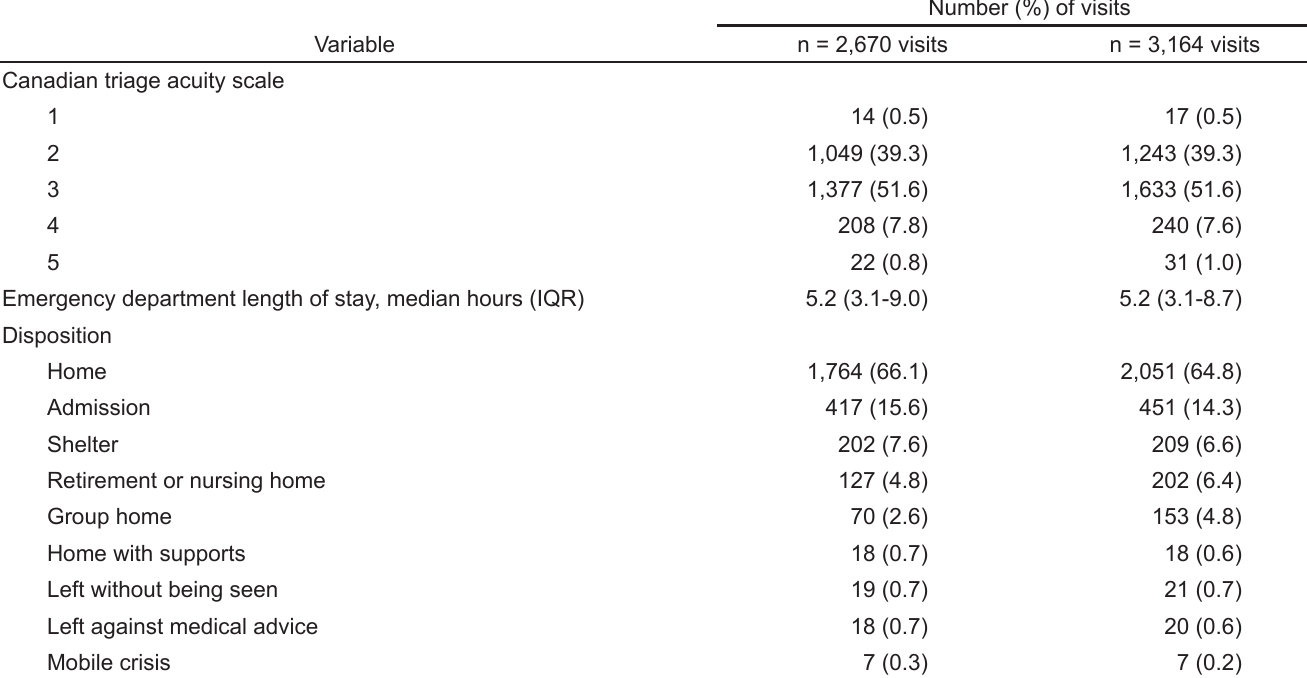
Table 2. Number and (percentage) of patients unless otherwise indicated.